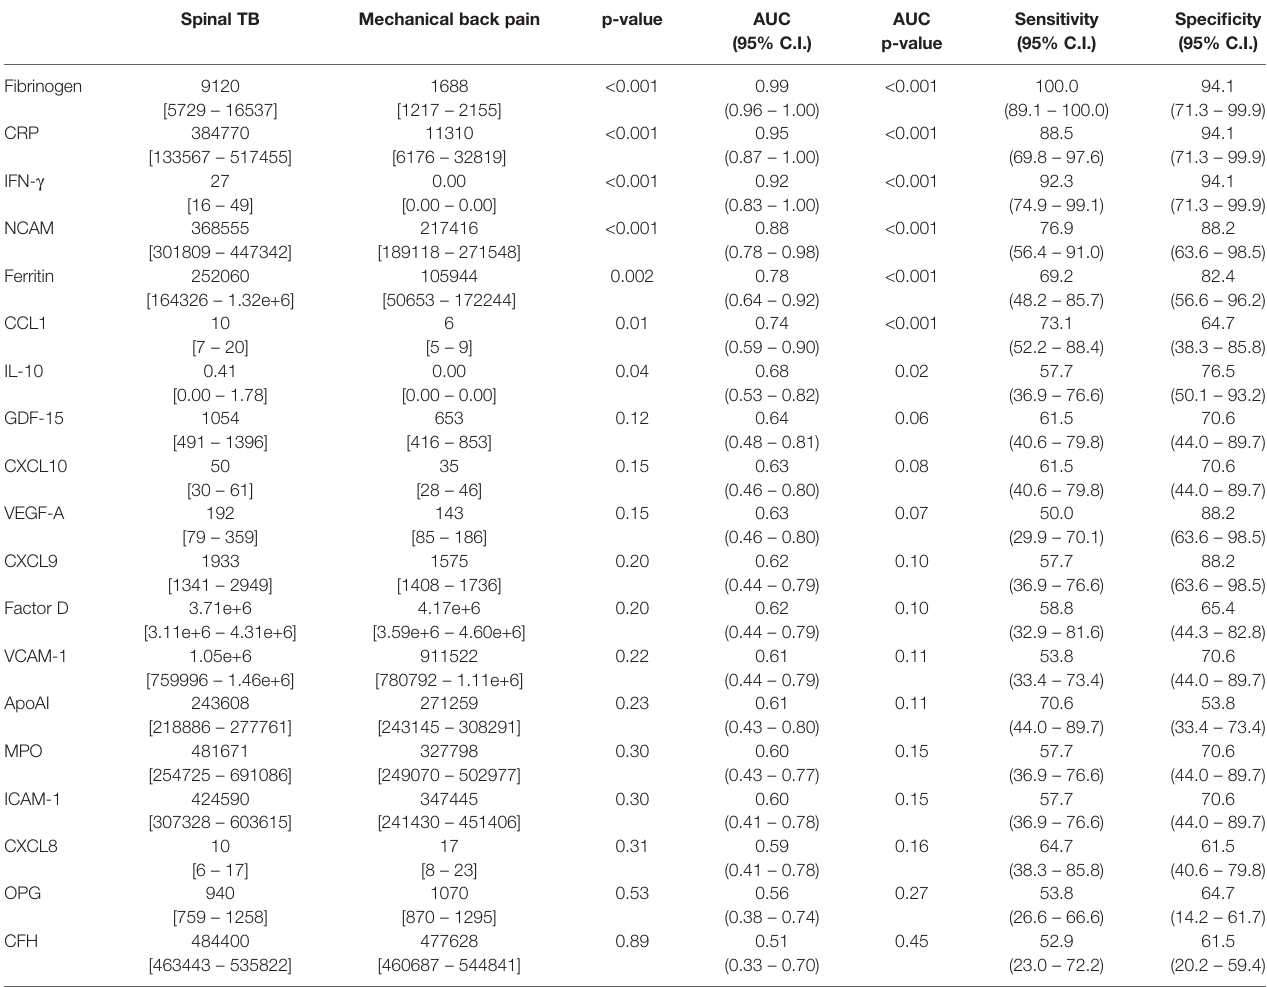
TABLE 3 | Biomarker levels and utility of individual biomarkers to distinguish between spinal TB and mechanical back pain. Spinal